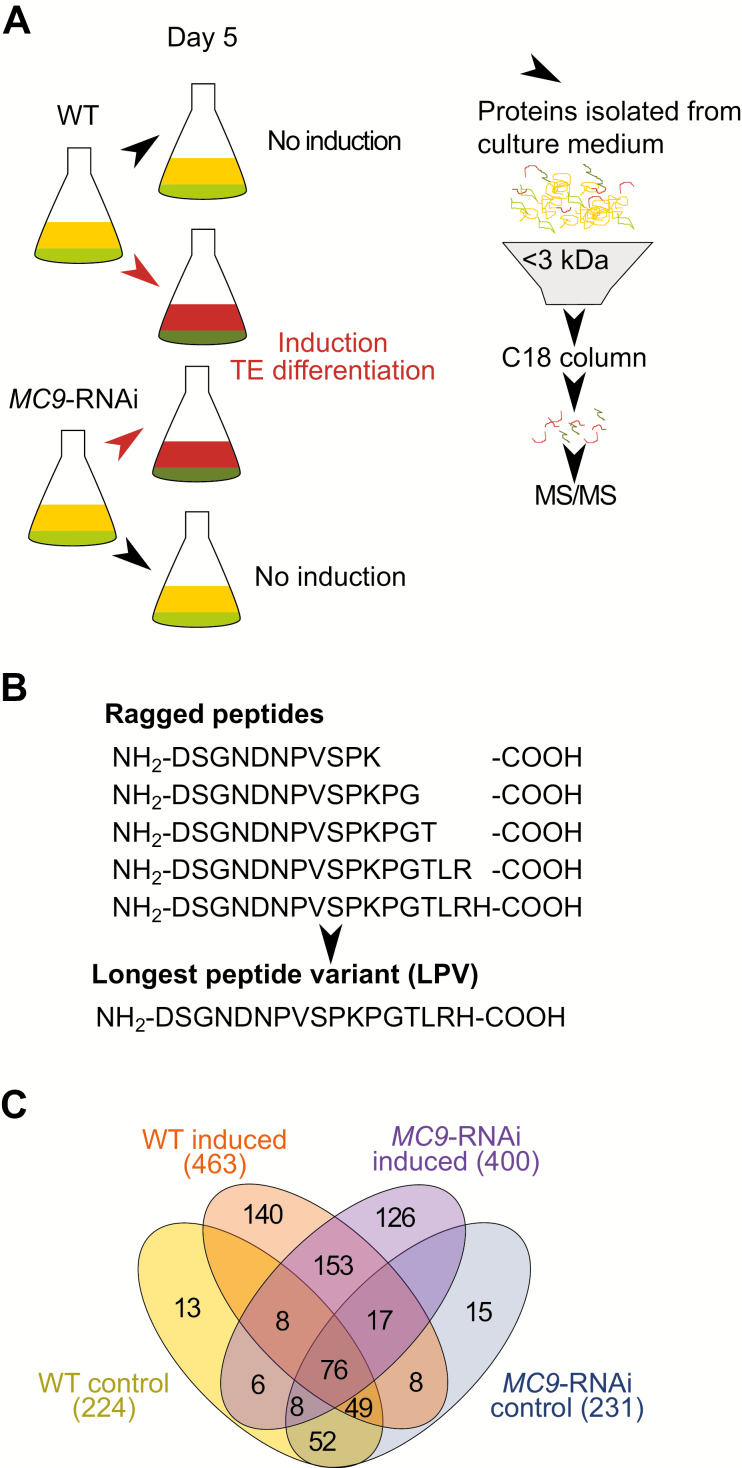
Peptidomics approach to identify METACASPASE9-regulated extracellular peptides. (A) Schematic representation of the bioactive peptide identification workflow. The extracellular media of differentiating cell suspensions were sampled 5 d after induction (n=3 biological replicates), half-way through the differentiation when MC9 expression peaks and when ectopic cell death starts increasing in MC9-RNAi lines (Escamez et al., 2016). (B) Visual explanation for the longest peptide variant (LPV) approach. (C) Venn diagram showing the number of unique peptides per genotype and per condition (induced or non-induced control).